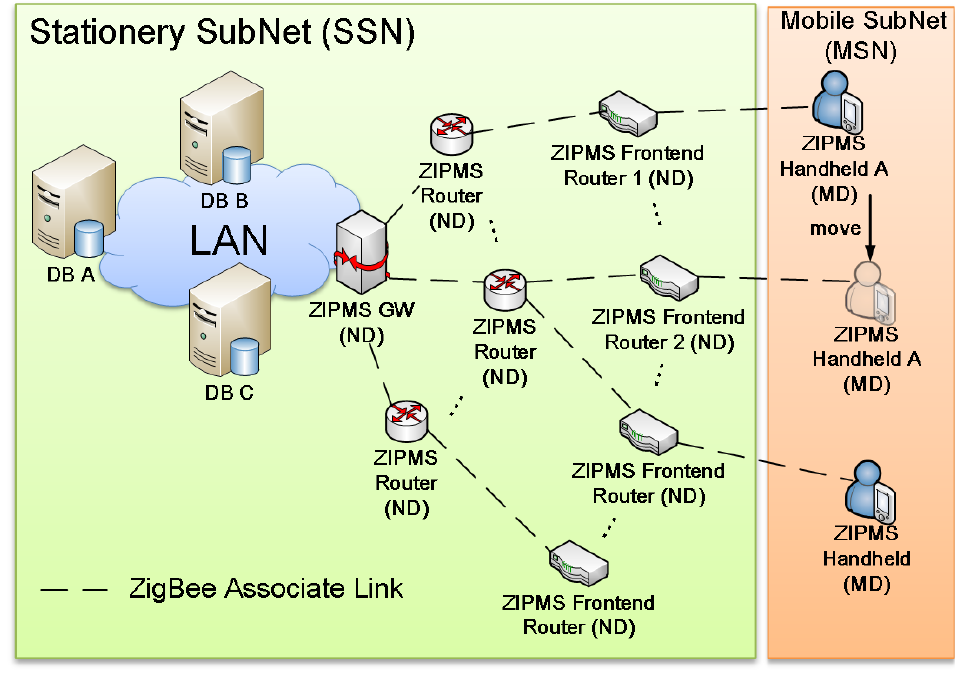
Figure 1. The ZigBee in-patient monitoring system (ZIPMS)